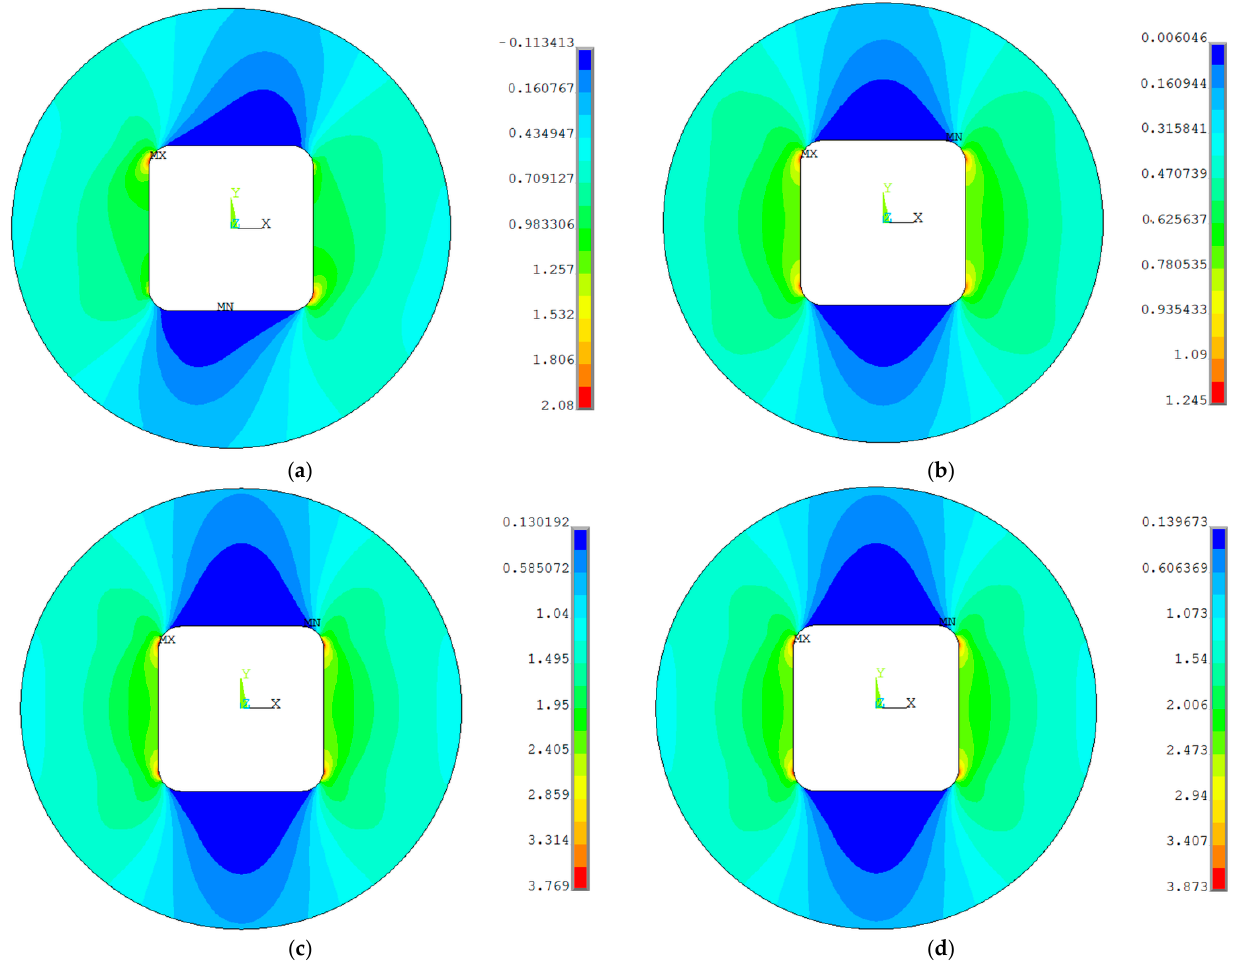
Figure 25. Distribution of tension stress σ ycomp for top composite layer, patch size: R ov = 20 mm, for different fiber angle orientation: ( a ) θ = ± 45 ◦ ; ( b ) θ = 90 ◦ ; ( c ) θ = 0 ◦ ; ( d ) θ = 0 ◦ /90 ◦